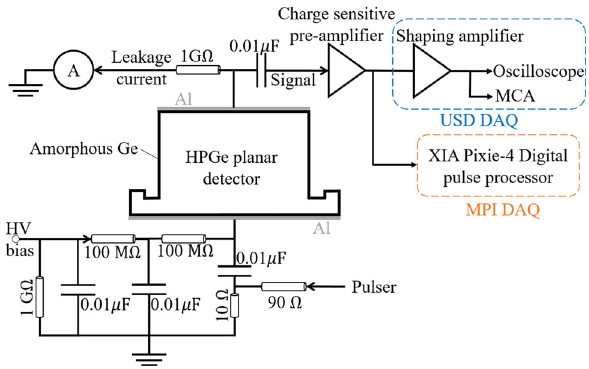
Fig. 3 Electronic circuit for detector characterization